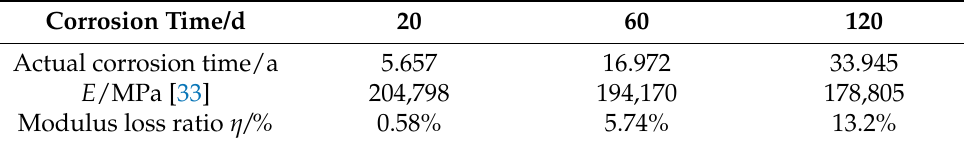
Table 6. The actual corrosion time and elastic modulus of corrosion